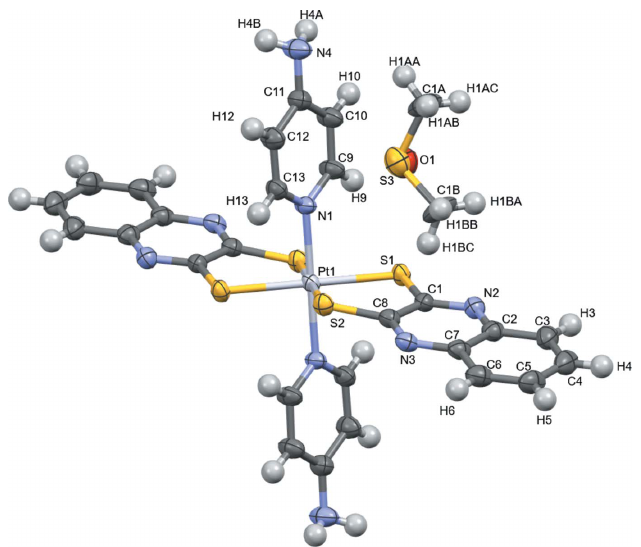
Figure 1 The molecular structure of the title complex drawn with displacement ellipsoids at the 50% probability level. Non-labeled atoms are generated by symmetry operation (cid:5) x + 1, (cid:5) y + 1, (cid:5) z . The disordered dmso solvate molecule is shown with only one